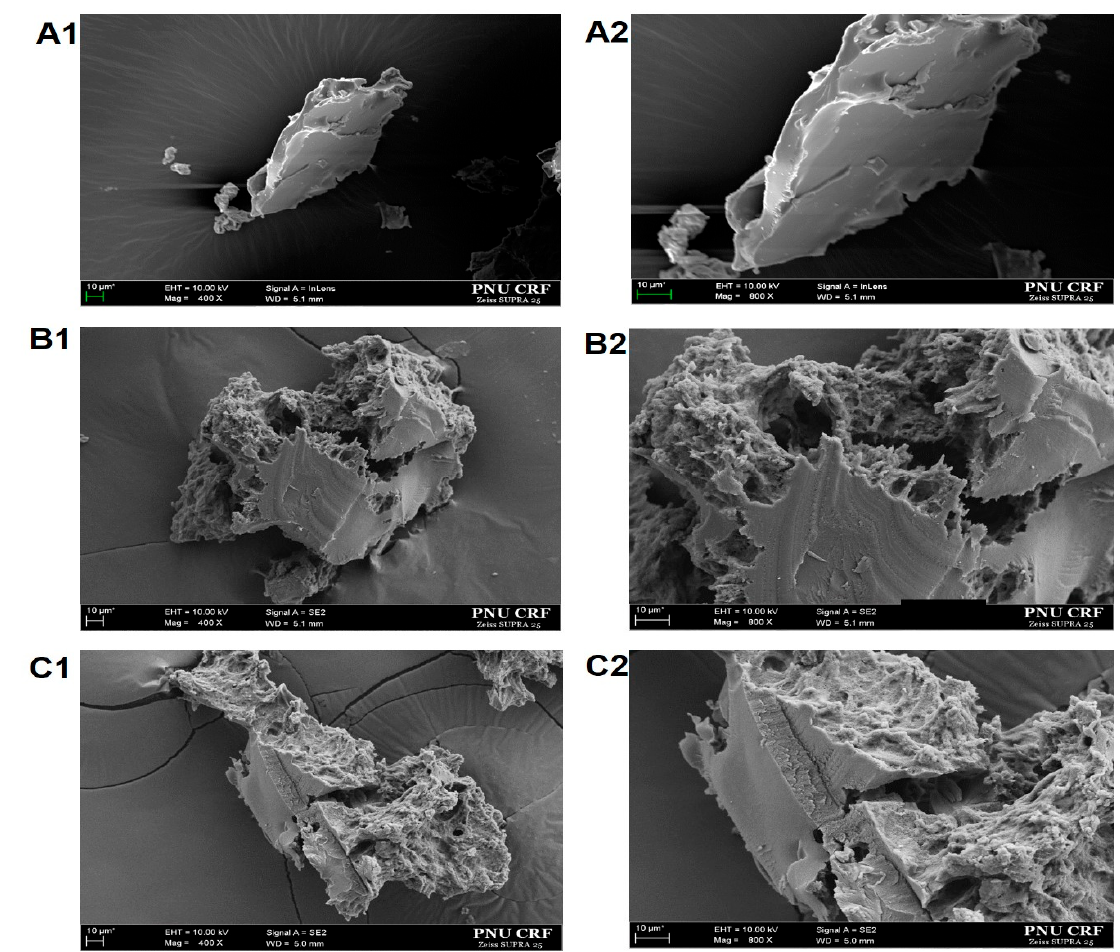
Figure 2. Field-emission scanning electron microscope images of the cross section of starch granules of ( A1 , A2 ) control starch, ( B1 , B2 ) 230 U-AS-treated starch, and ( C1 , C2 ) 460 U-AS-treated starch. Magnifications: ( A1 , B1 , C1 ), ×400, and ( A2 , B2 , C2 ), ×800.